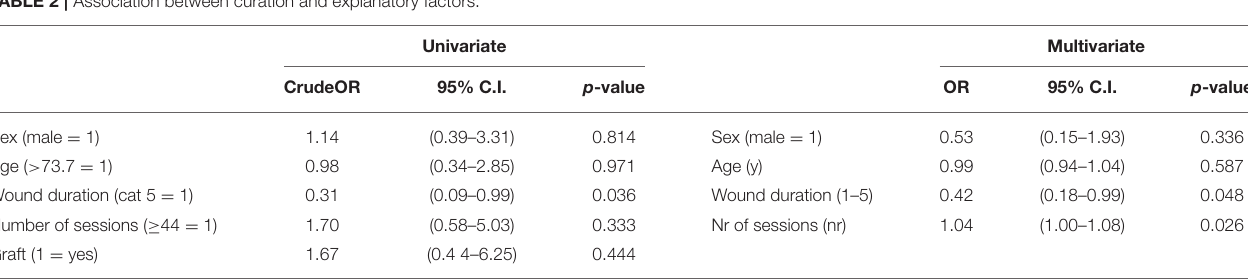
TABLE 2 | Association between curation and explanatory factors. Univariate Multivariate CrudeOR 95% C.I. p -value OR 95%